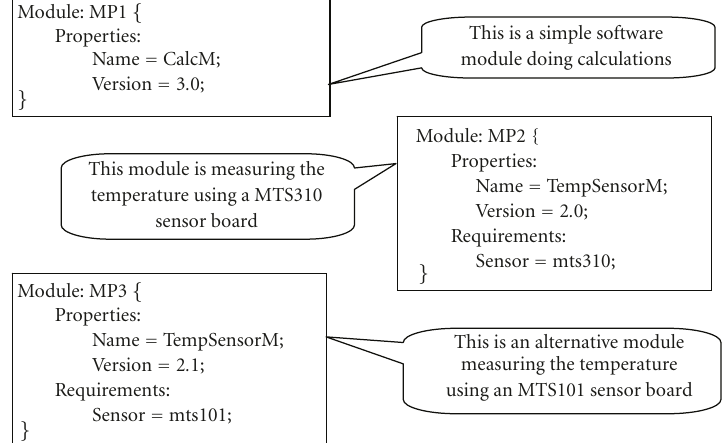
Figure 5: Sample profiles describing single software